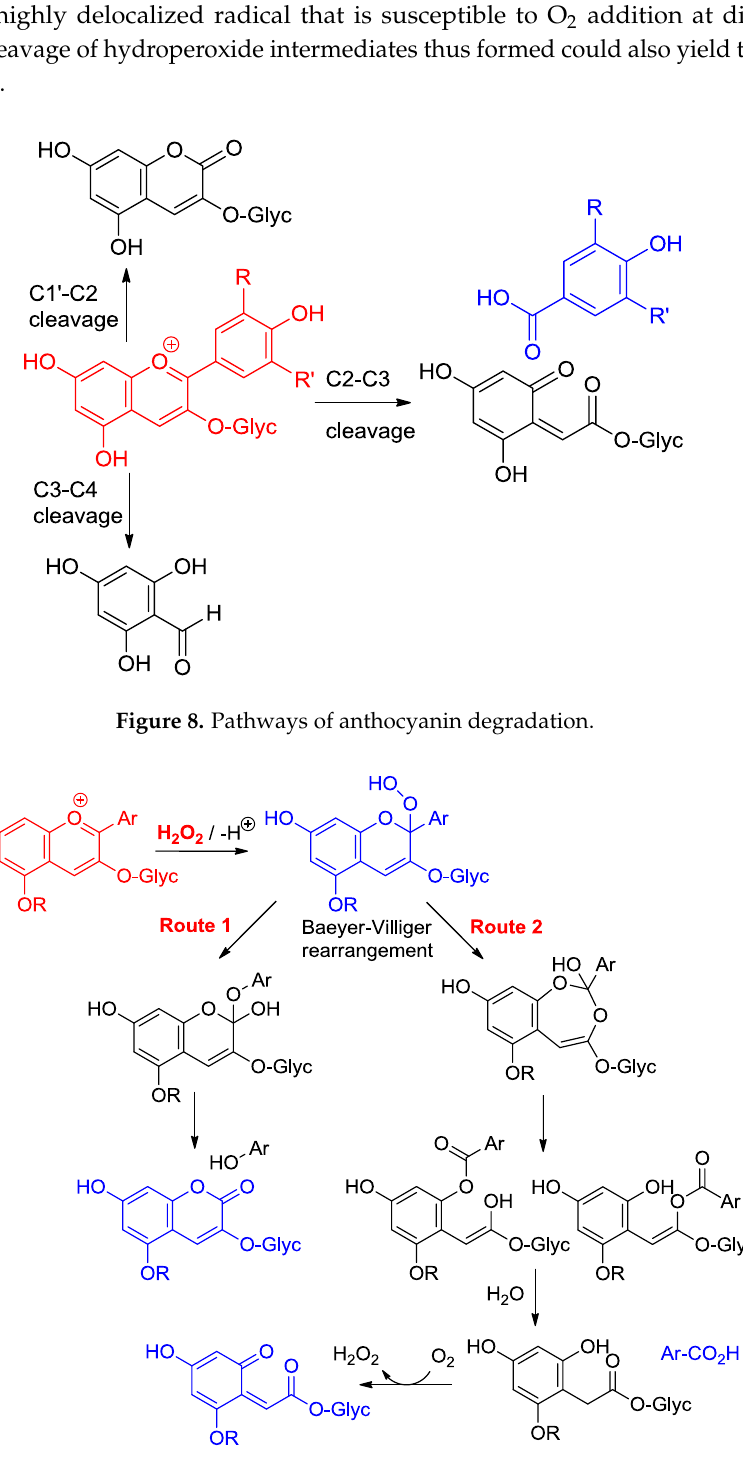
Figure 9. Possible mechanisms of anthocyanin degradation with pre-formed hydrogen peroxide.